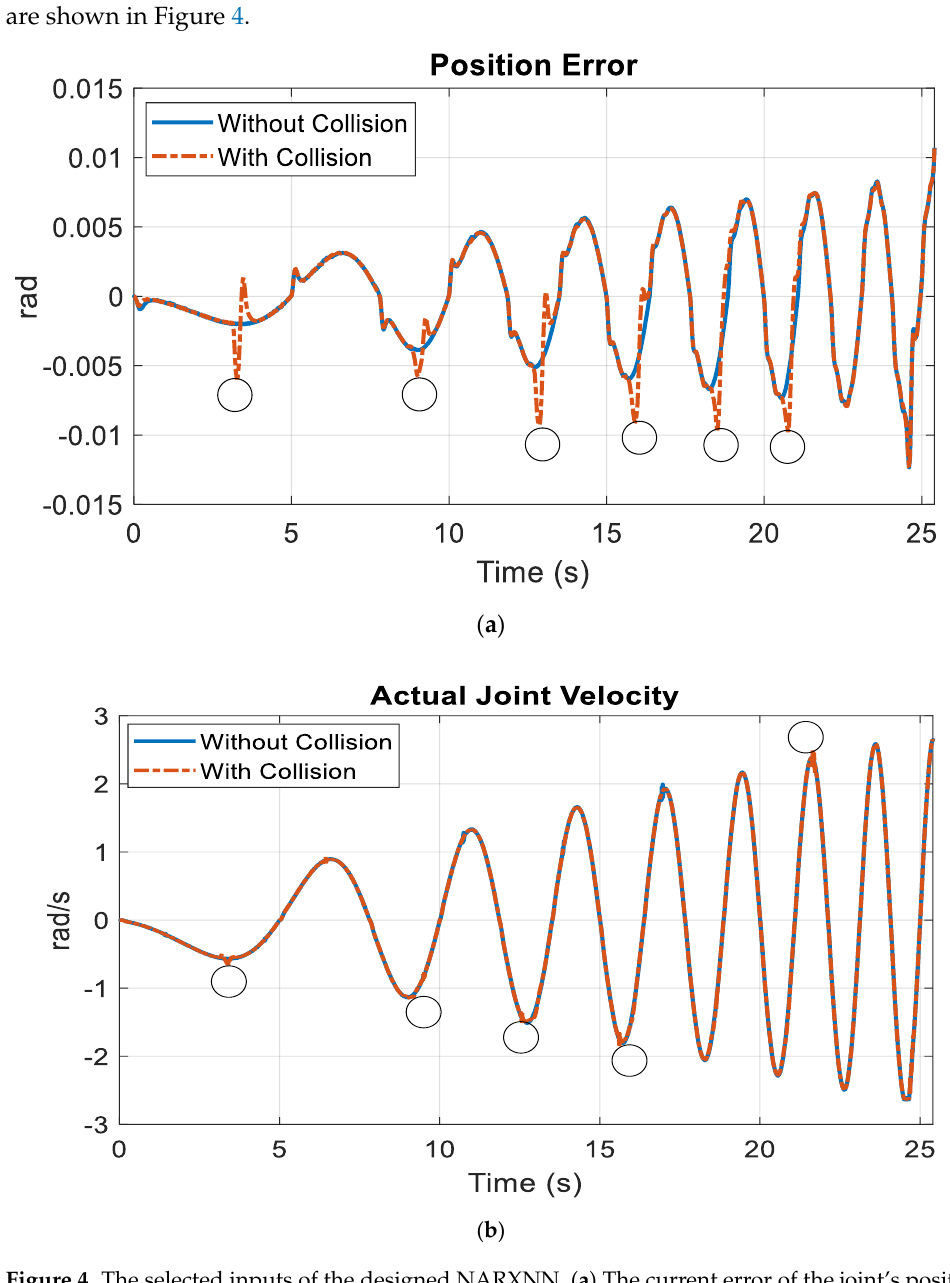
Figure 4. The selected inputs of the designed NARXNN. ( a ) The current error of the joint’s position. ( b ) The actual velocity of the joint.